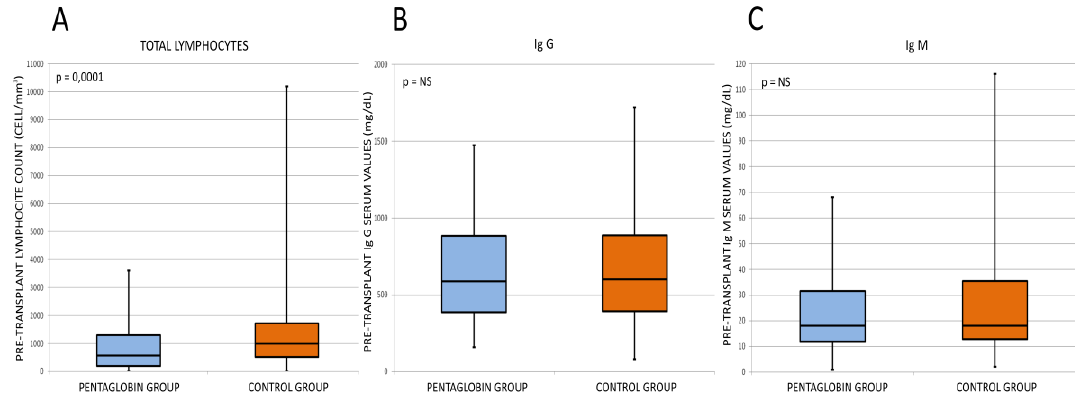
Figure 2. Pre-transplant immunological status of patients in two study groups.